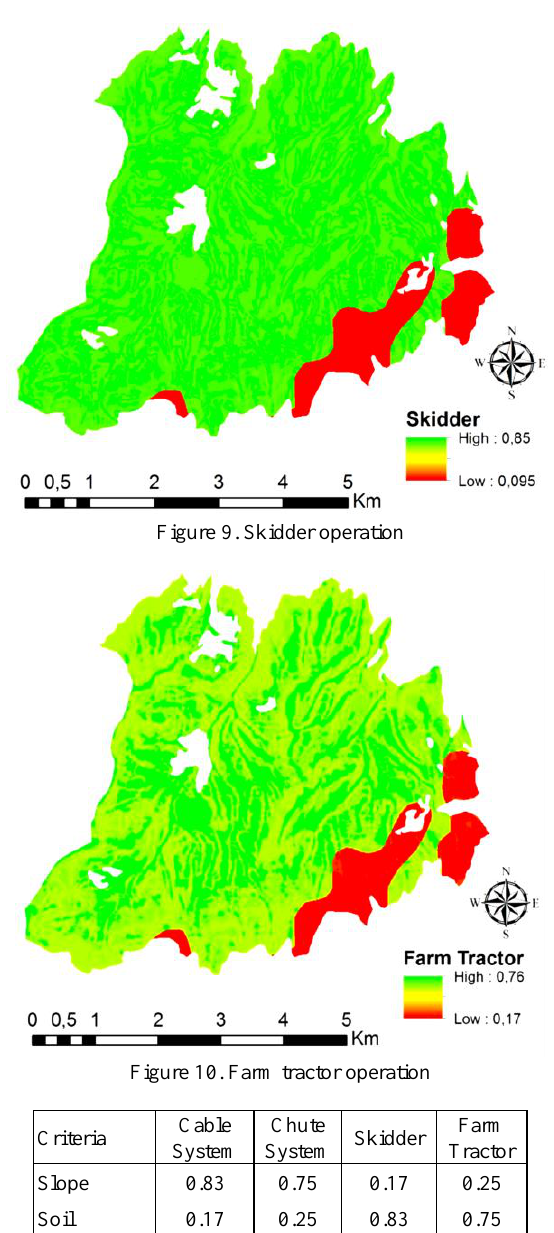
Table 7. The weighted values of criteria Table 8 indicates areal distribution of optimum transportation methods with the highest weighted average with respect to all the criteria. The results showed that skidder method was suggested as optimum method for 59.1% of the study area (Figure 11). The chute system was the second most favourable system (25.17%) in the study area. Cable system and chute system were the optimal methods for 9.47% and 6.26% of the study area, respectively.